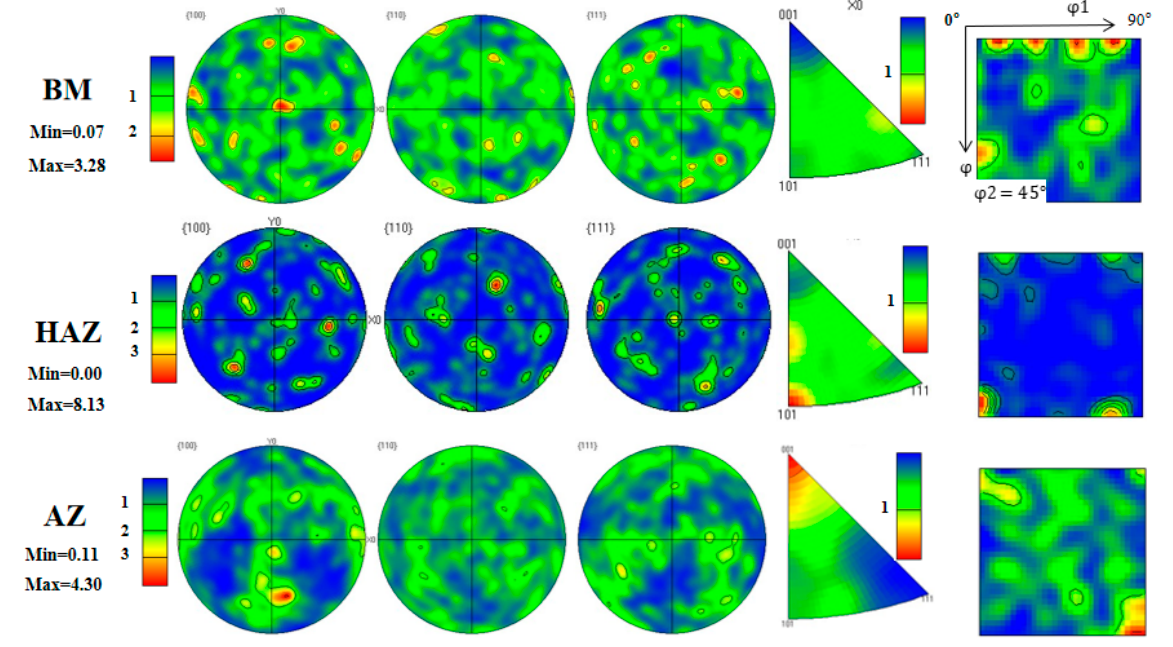
Figure 7. Corresponding pole image, reverse pole image, and ODF image of each area of the sample after 80 mm/min electron beam scanning ( φ2 = 45° ).